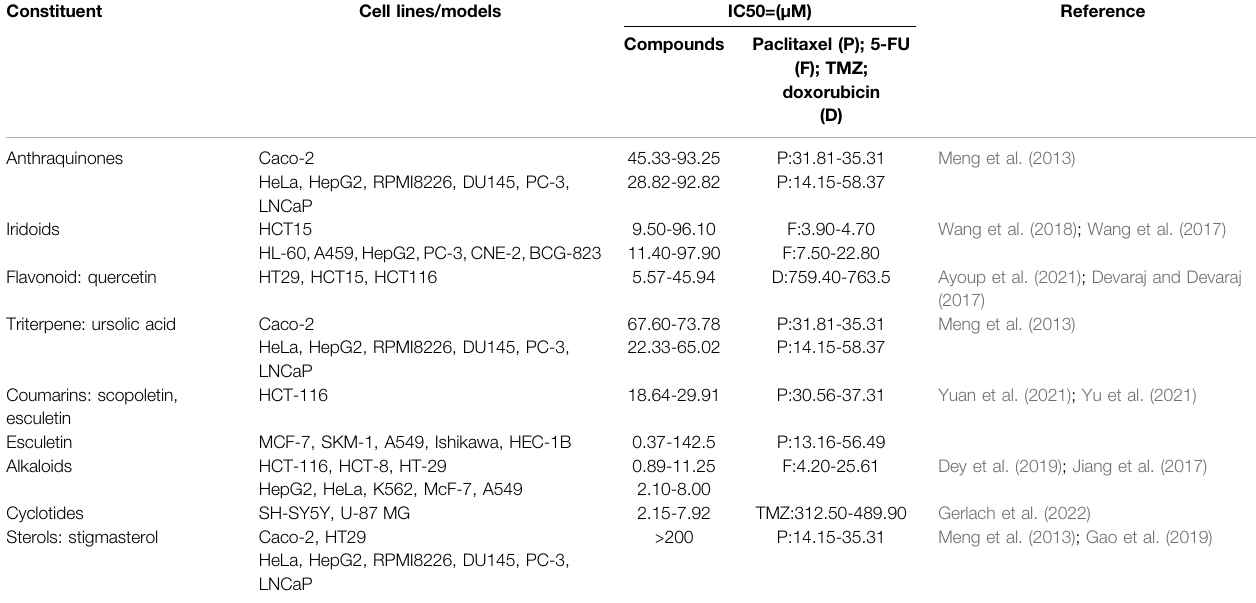
TABLE 2 | Representative antitumor constituents isolated from the